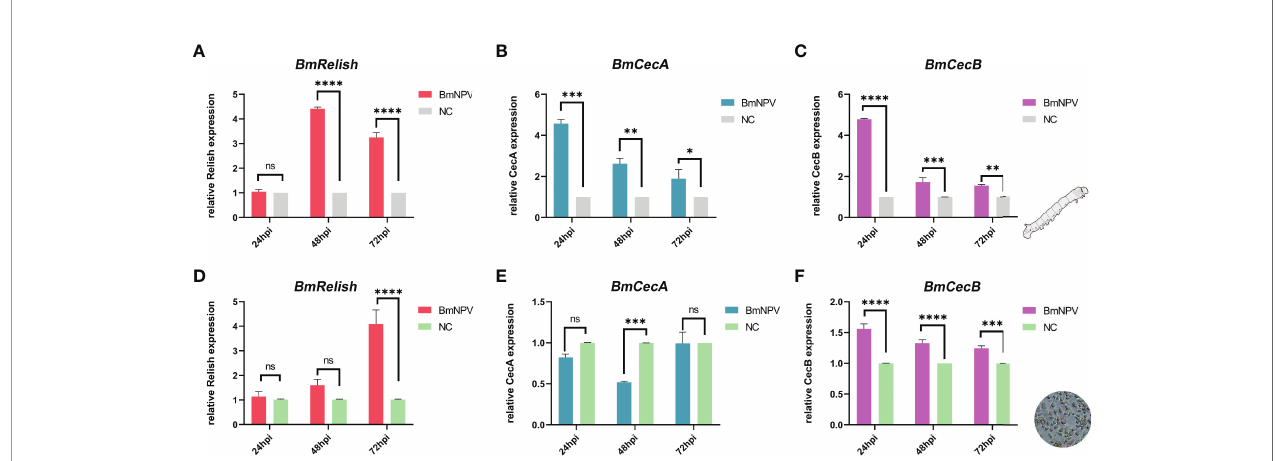
FIGURE 7 | Induction of BmRelish expression after BmNPV infection. (A – C) Quanti fi cation of the expression of BmRelish , CecA and CecB by qRT-PCR in the fat body of virus-infected silkworm larvae. (D – F) Quanti fi cation of the expression of BmRelish , CecA and CecB in BmN cells by qRT-PCR at 24, 48 and 72 h after BmNPV infection. Negative control corresponds to uninfected samples. Each bar represents the mean ± SD. *p < 0.05, **p < 0.01, ***p < 0.001, ****p < 0.0001. ns, not signi fi cant.